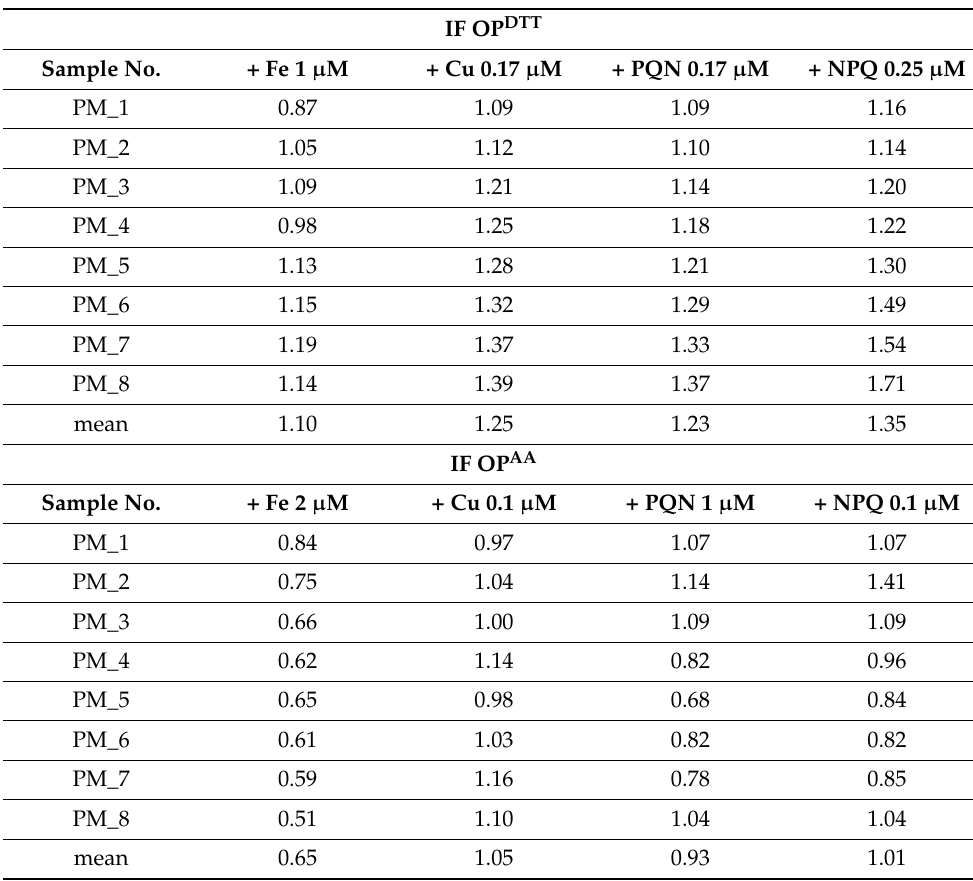
Table 4. Interaction factors for DTT and AA consumption in the real-world PM 2.5 samples after addition of standard solutions of Cu and Fe metals and of PQN and NPQ quinones. IF OP DTT Sample No. + Fe 1 µ M + Cu 0.17 µ M + PQN 0.17 µ M + NPQ 0.25 µ